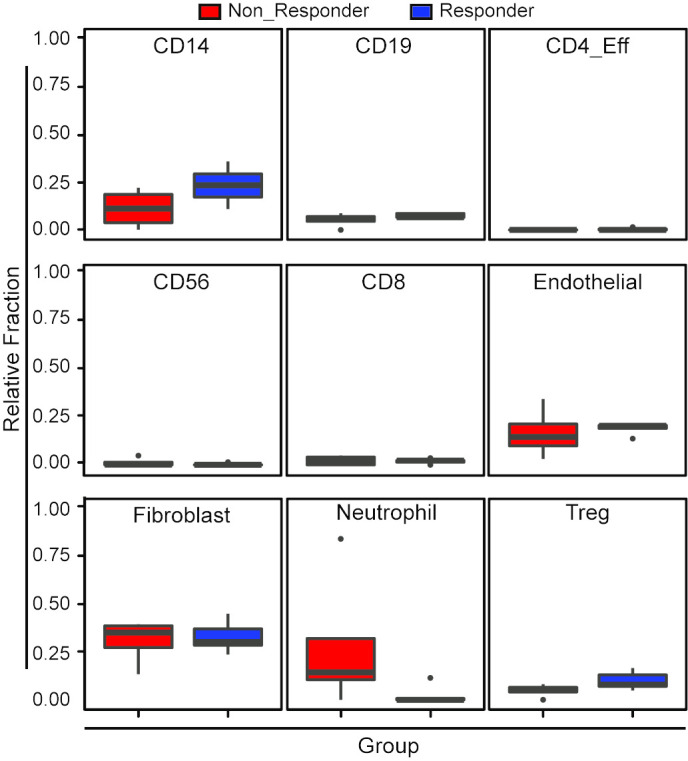
Variability in immune cell subpopulations in both responding and non-responding GBM patients with administration of a PD-1 inhibitor (nivolumab).Immune cell subpopulation DNA methylation signatures of patients on PD-1 immunotherapy are deconvoluted using methylCIBERSORT. Noted that Repsonders and who showed no response to nivolumab do not show any significant differences in relative fractions of immune and stromal cells. p-Value of Wilcoxon test for CD14, CD19, CD4_Eff, CD56, CD8, endothelial, fibroblast, neutrophil and regulatory T cells (Treg) is 0.18; 0.39; 0.24; 0.47; 0.9; 0.39; 0.9; 0.12 and 0.27, respectively.